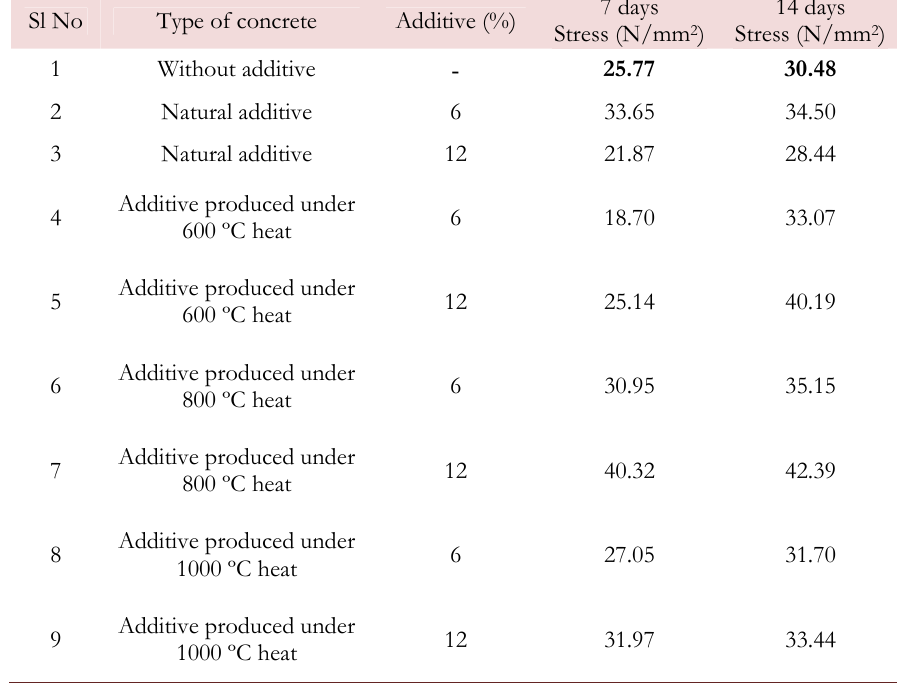
Table 2: Concrete compression